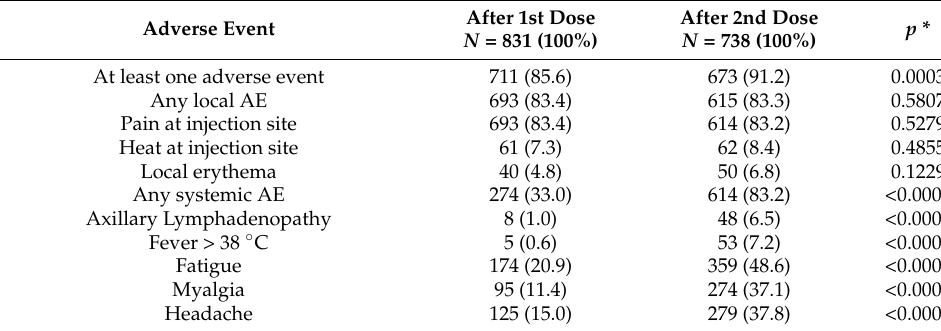
Table 2. Adverse events rate after first and second